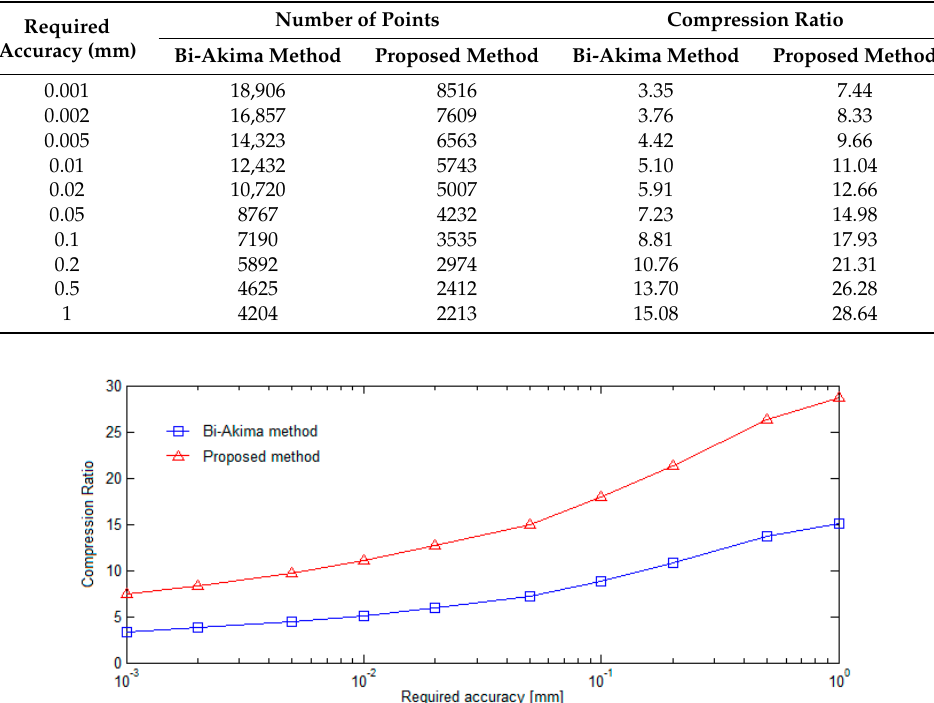
Figure 11. Spatial distribution of initial point cloud data. Table 3. Compression performance under different required accuracies.